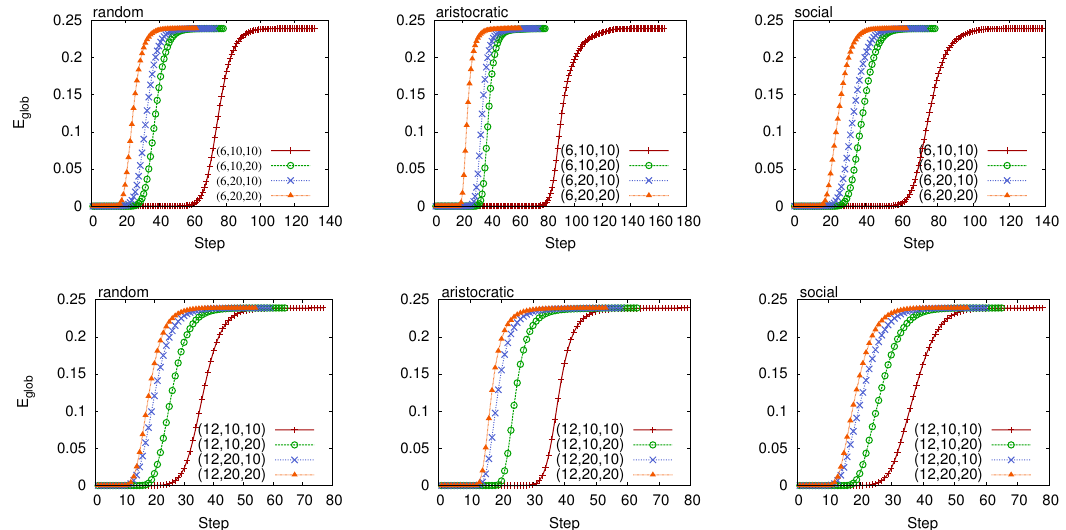
Figure 18. Accelerated analysis with mermaids fixing m = 6 ( top plots ) and m = 12 ( bottom plots ), random, aristocratic, and social rules, word of mouth model (for mermaids’ dynamics). Communities online social network.